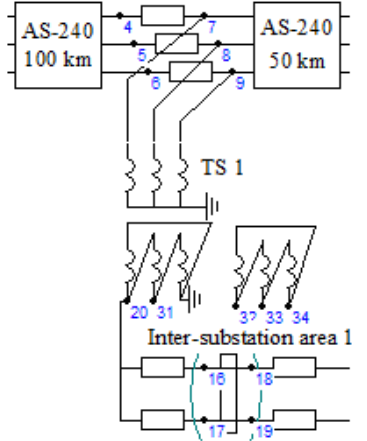
Figure 13. Detail of the computational model circuit.